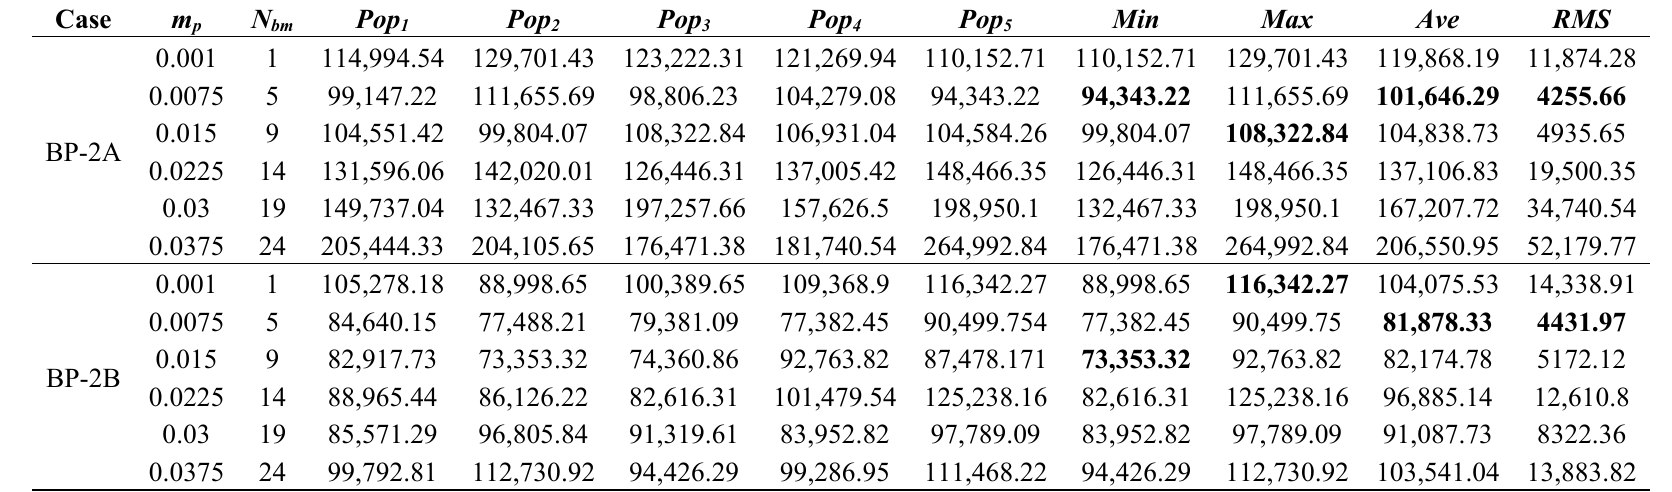
Table 8. Biggiero and Pianese (1996) [64] case study. Optimal results for the cases BP-2A and